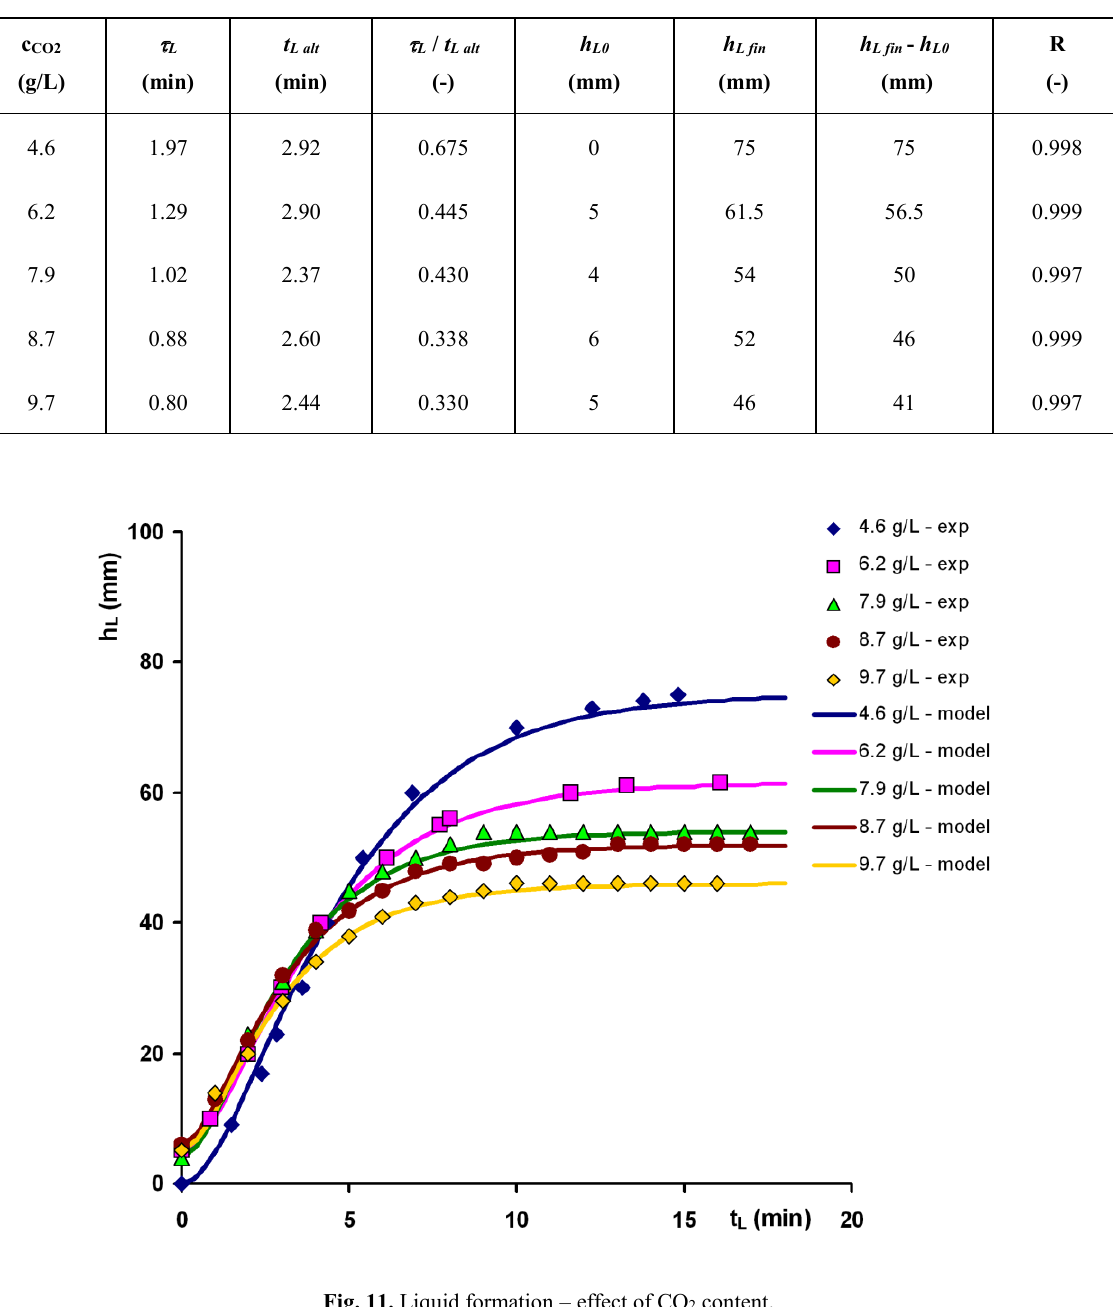
Fig. 11. Liquid formation – effect of CO 2 content